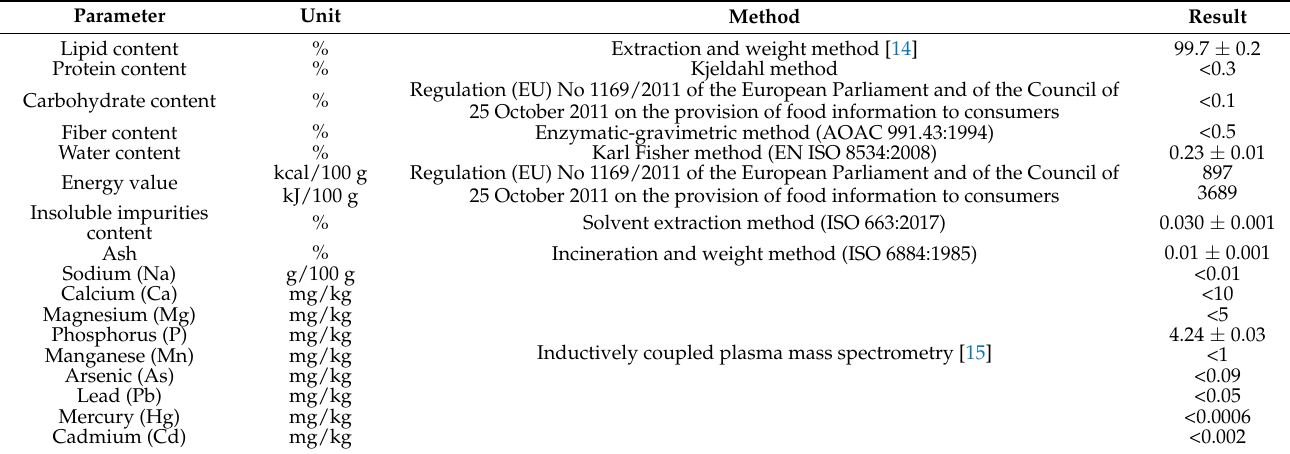
Table 1. Chemical parameters of waste fish oil originated from fish smoking